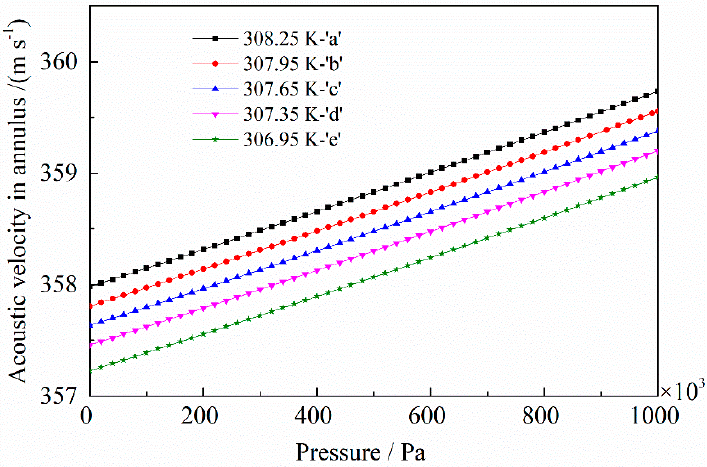
Figure 11. Acoustic velocity in the annulus under different experimental conditions.